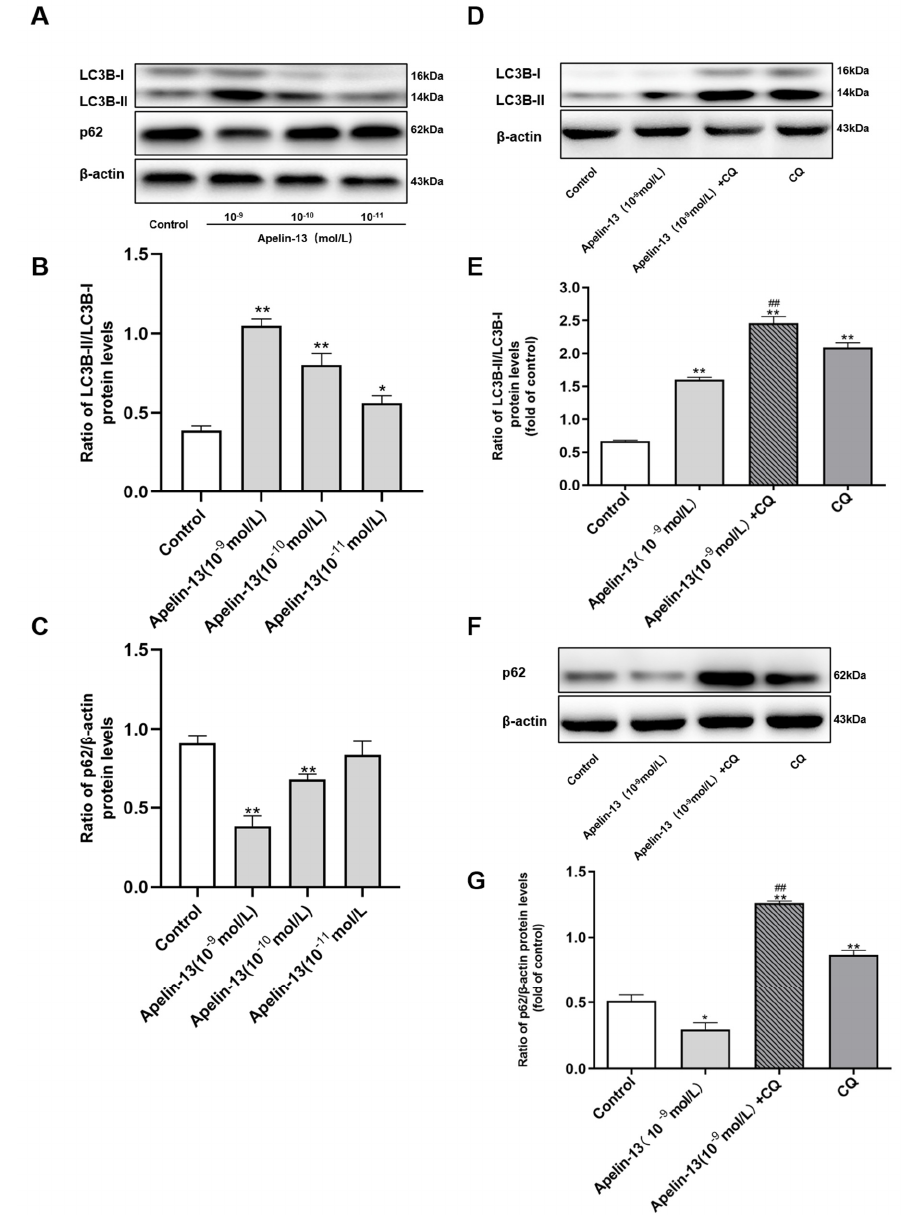
Figure 3. Autophagy activation in SH-SY5Y cells with apelin-13 treatment. ( A – C ) SH-SY5Y cells were treated with apelin-13 (10 − 11 mol / L ~ 10 − 9 mol / L) for 24 h. Western blot was applied to detect the expression of light chain 3B (LC3B)-II / LC3B-I and p62. The ratio of LC3B-II / LC3B-I was increased dose-dependently with apelin-13 (10 − 10 mol / L ~ 10 − 9 mol / L) treatment, while the expression of p62 was reduced as compared with the control. ( D – G ) SH-SY5Y cells were treated with apelin-13 or co-treated with apelin-13 and CQ (10 µ M). The ratio of LC3B-II / LC3B-I and the expression of p62 were increased in the presence of CQ, and further increased with apelin-13 and CQ in SH-SY5Y cells. Data are presented as mean ± SEM of three replications. * p < 0.05; ** p < 0.01 compared with the control; ## p < 0.01 compared with the apelin-13